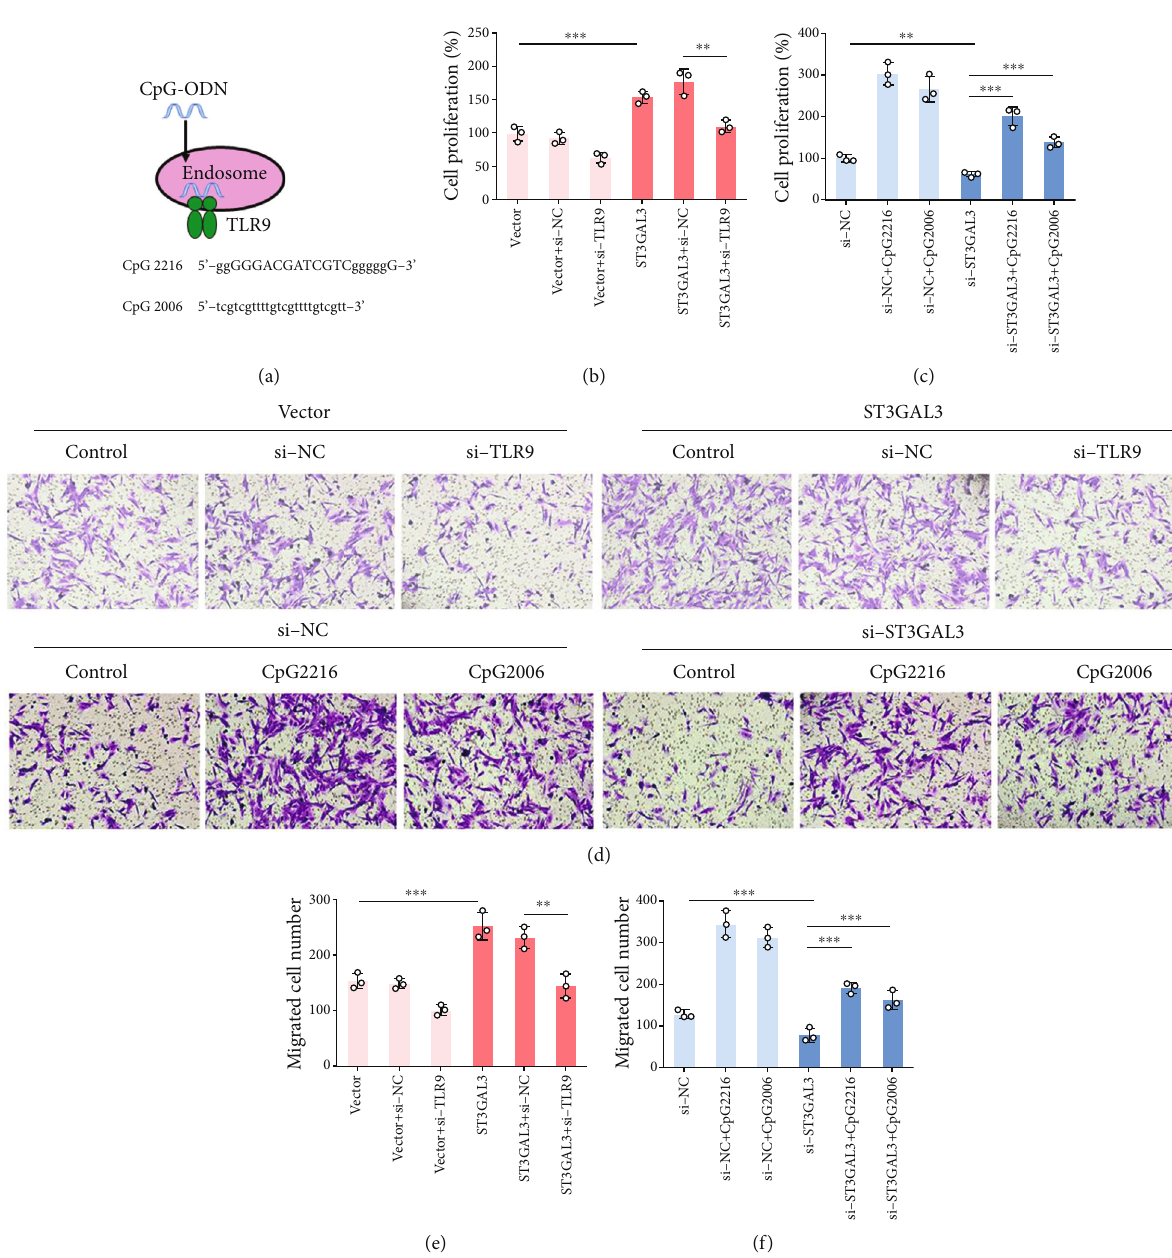
Figure 6: ST3GAL3 promoted the proliferation and migration of MH7A cells by activating the TLR9/MyD88 pathway. (a) The sequences of CpG-ODNs (CpG 2216 and CpG 2006). (b) MTT assay results showed that transfection of MH7A cells with si-TLR9 reversed the e ff ects of ST3GAL3 on cell proliferation. (c) MTT assay results showed that adding with CpG-ODNs reversed the e ff ects of si-ST3GAL3 on MH7A cell proliferation. (d) Representative images of cell migration from transwell assay. (e) Transwell assay results showed that transfection of MH7A cells with si-TLR9 reversed the e ff ects of ST3GAL3 on cell migration. (f) Transwell assay results showed that adding with CpG-ODNs reversed the e ff ects of si-ST3GAL3 on MH7A cell migration. n = 3 . ∗∗ p < 0 : 01 and ∗∗∗ p < 0 : 001 compared with the indicated